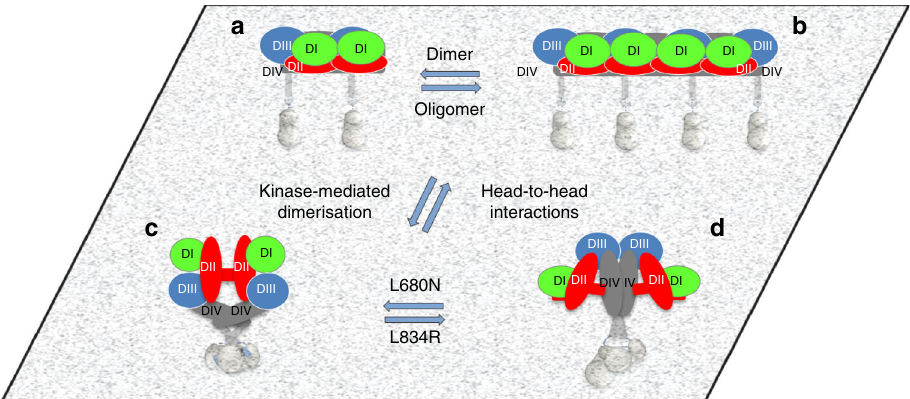
Fig. 8 Cartoon models of ligand-free EGFR species on the cell surface. a, b Autoinhibited ligand-free receptors form a dimers and b larger oligomers via extracellular head-to-head interactions. Within head-to-head dimers and oligomers the ICMs remain as non-interacting units. c , d Kinase-mediated receptor dimerisation outcompetes head-to-head interactions to form two types of receptor dimers that typically coexist in equilibrium (bearing aTKD and sTKD dimer con fi gurations). Head-to-head dimers and oligomers are disrupted by kinase-mediated dimerisation independently of whether the driver mutation and/or treatment is activating or not. The ECM architecture of one dimer type is consistent with a back-to-back dimer and structurally coupled